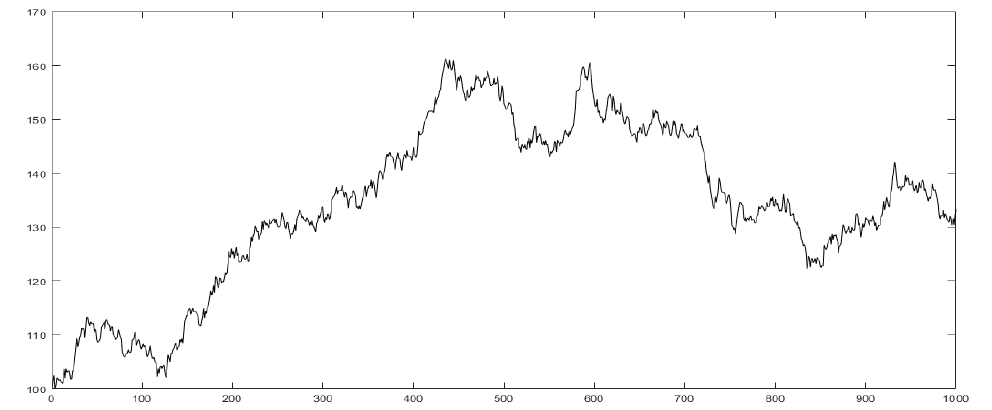
Figure 1. Simulation of a financial signal based on the sum of independent random walks; basis for the Random Walk